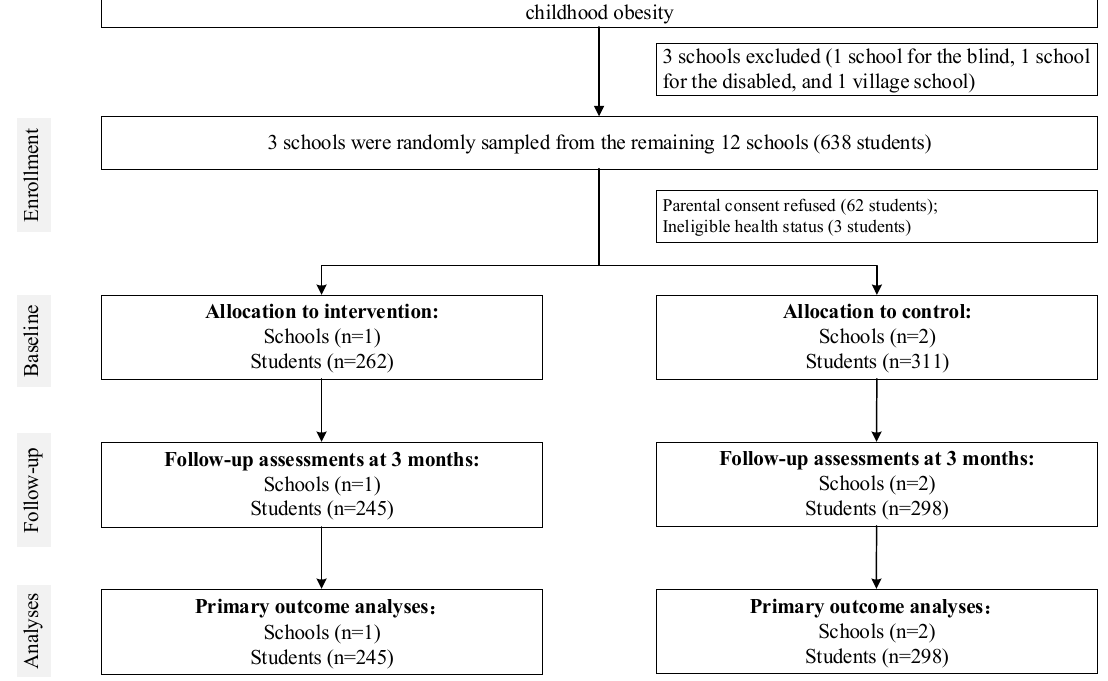
Figure 1. Trial Figure 1 Trial profile Figure 1. Trial profile.